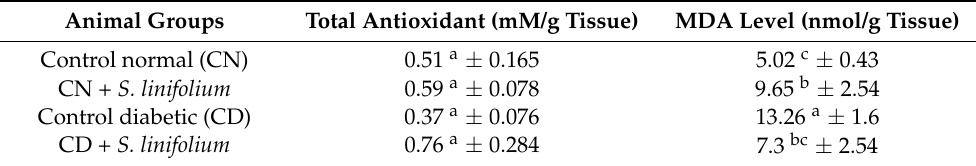
Table 7. Total antioxidant capacity and MDA levels in the differently treated rats. Animal Groups